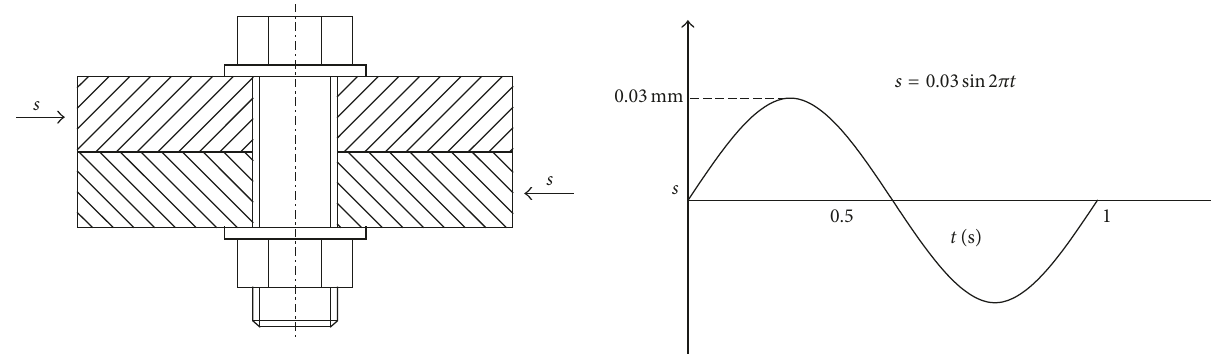
Figure 15: The diagrams of transversal harmonic